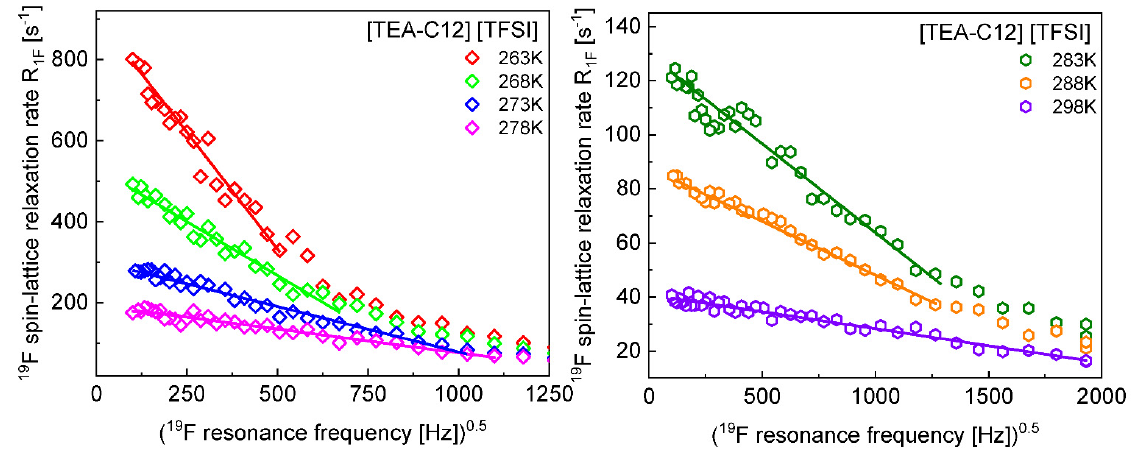
Figure A3. 19 F spin-lattice relaxation data for [TEA − C12] [TFSI] versus the squared root of the resonance frequency; solid lines represent linear fits in the low frequency range.